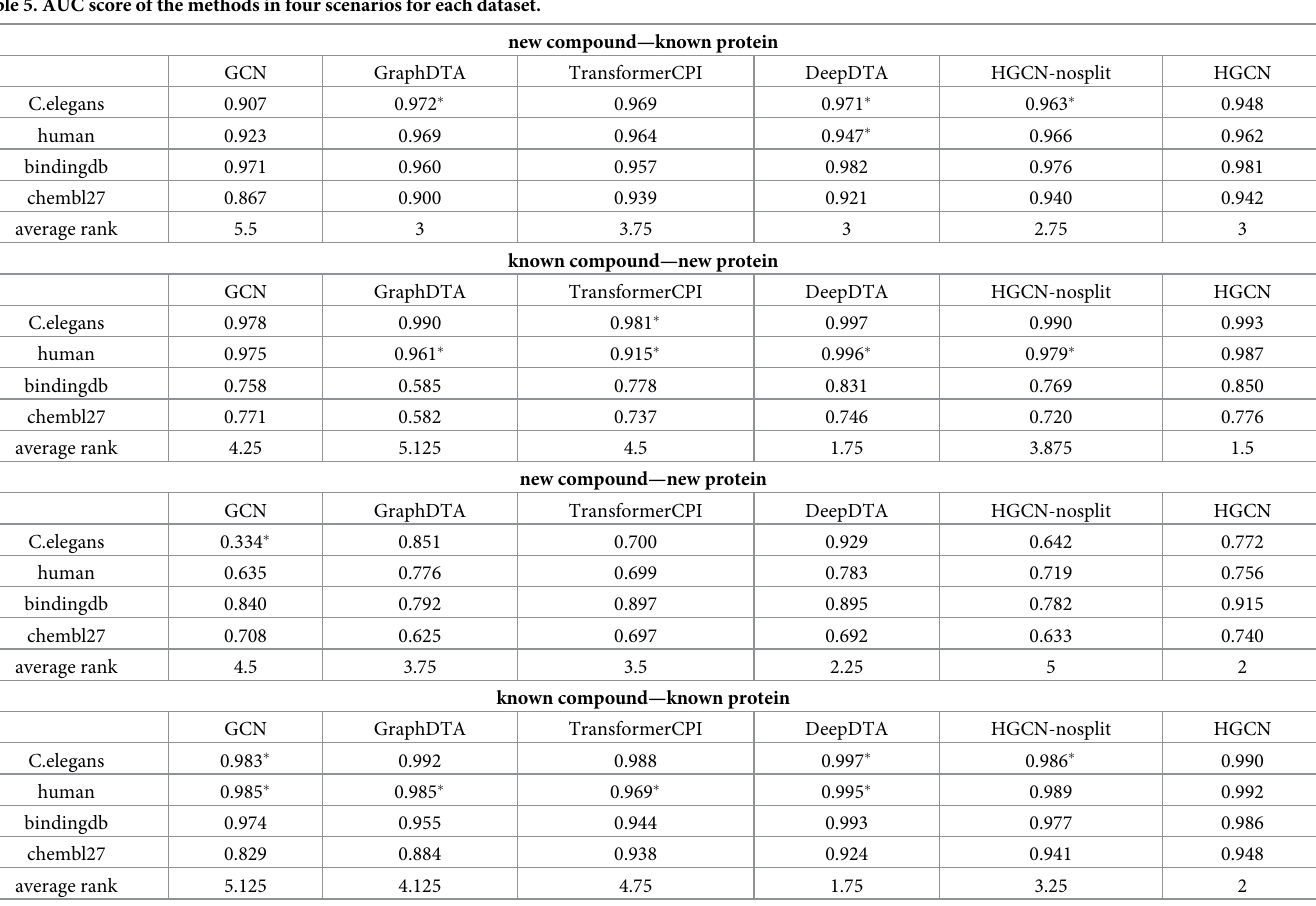
Table 5. AUC score of the methods in four scenarios for each dataset.